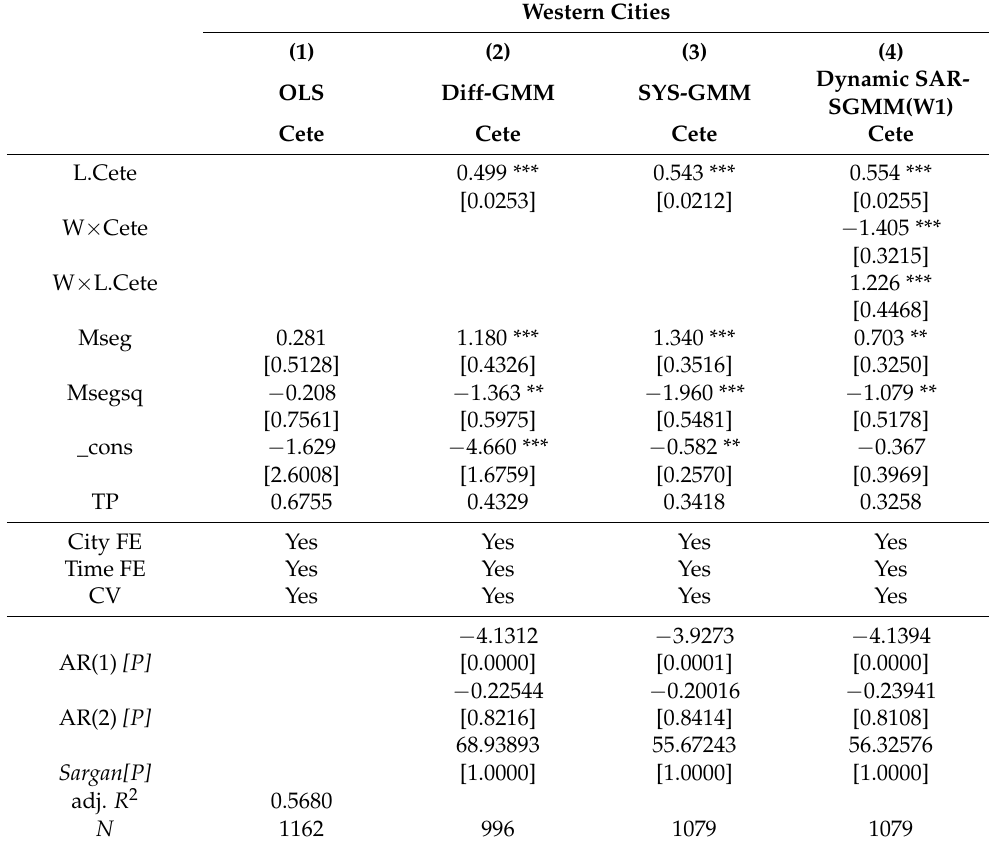
Table 10. Heterogeneity analysis regression